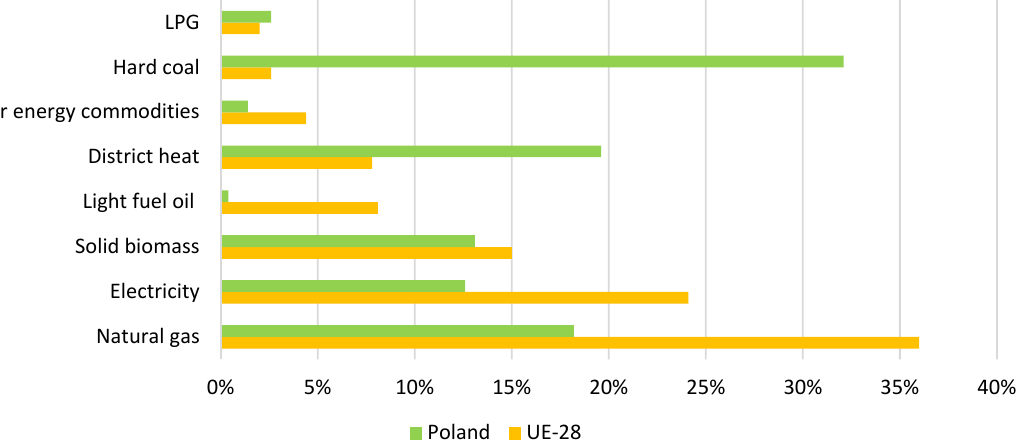
Figure 2. Structure of households energy consumption per inhabitant by various energy commodities in the EU-28 and in the Poland in 2017. Source: own study based on [1] .